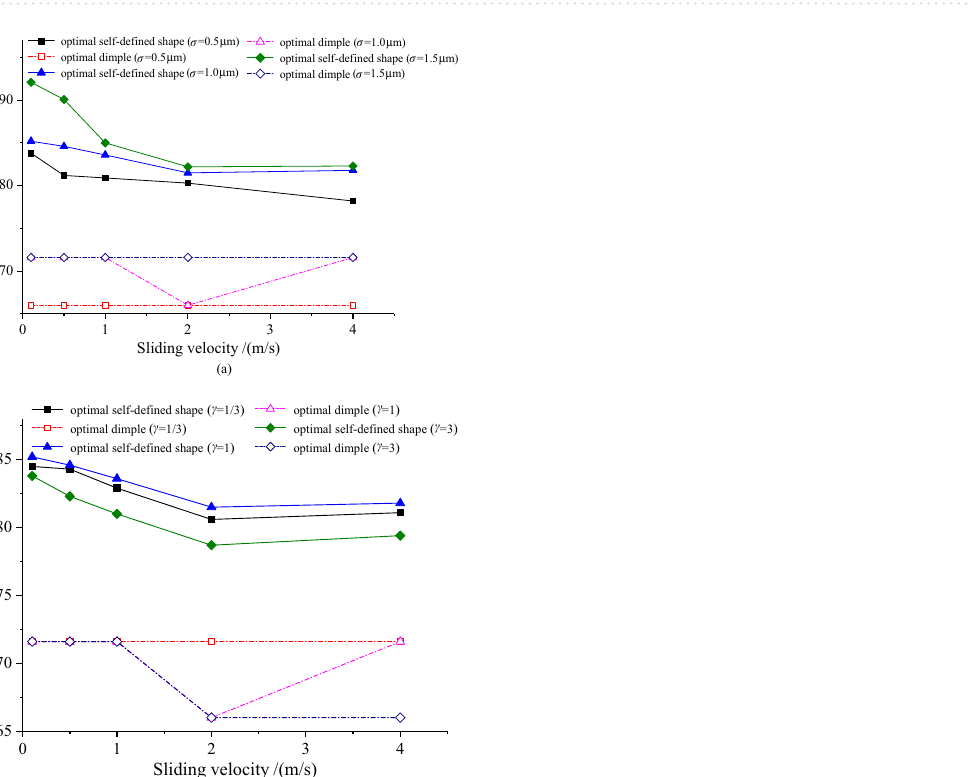
Figure 11. Variation of the area ratio with the minimum film thickness.